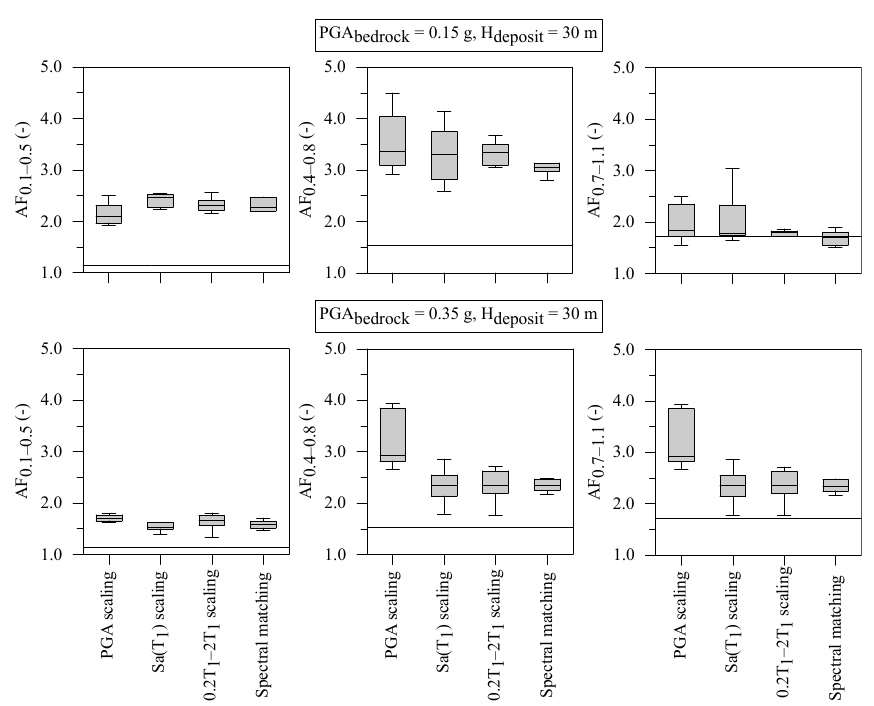
Figure 10. Box plots of AFs for a deposit thickness equal to 30 m and V S1 (z), considering 4 selection strategies for the input motions. The constant value retrieved from EC8 (thin black line) refers to ground type C.